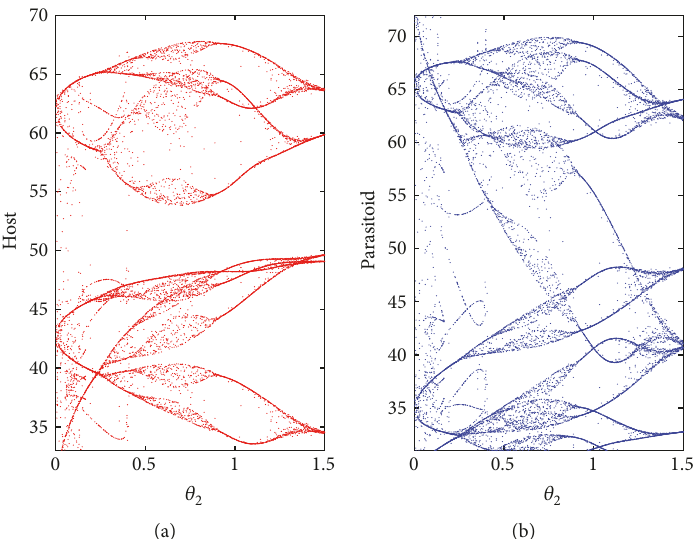
Figure 5: Bifurcation diagram of model (3) with 𝜃 2 . Parameters are fixed as 𝑟 = 0.8343 , 𝑎 = 0.045 , 𝜎 = 0.5 , 𝑞 𝑚𝑎𝑥 1 = 0.5 , 𝜃 1 = 3 , 𝑞 𝑚𝑎𝑥 2 = 0.5 , 𝜏 = 2 , 𝑞 = 3.